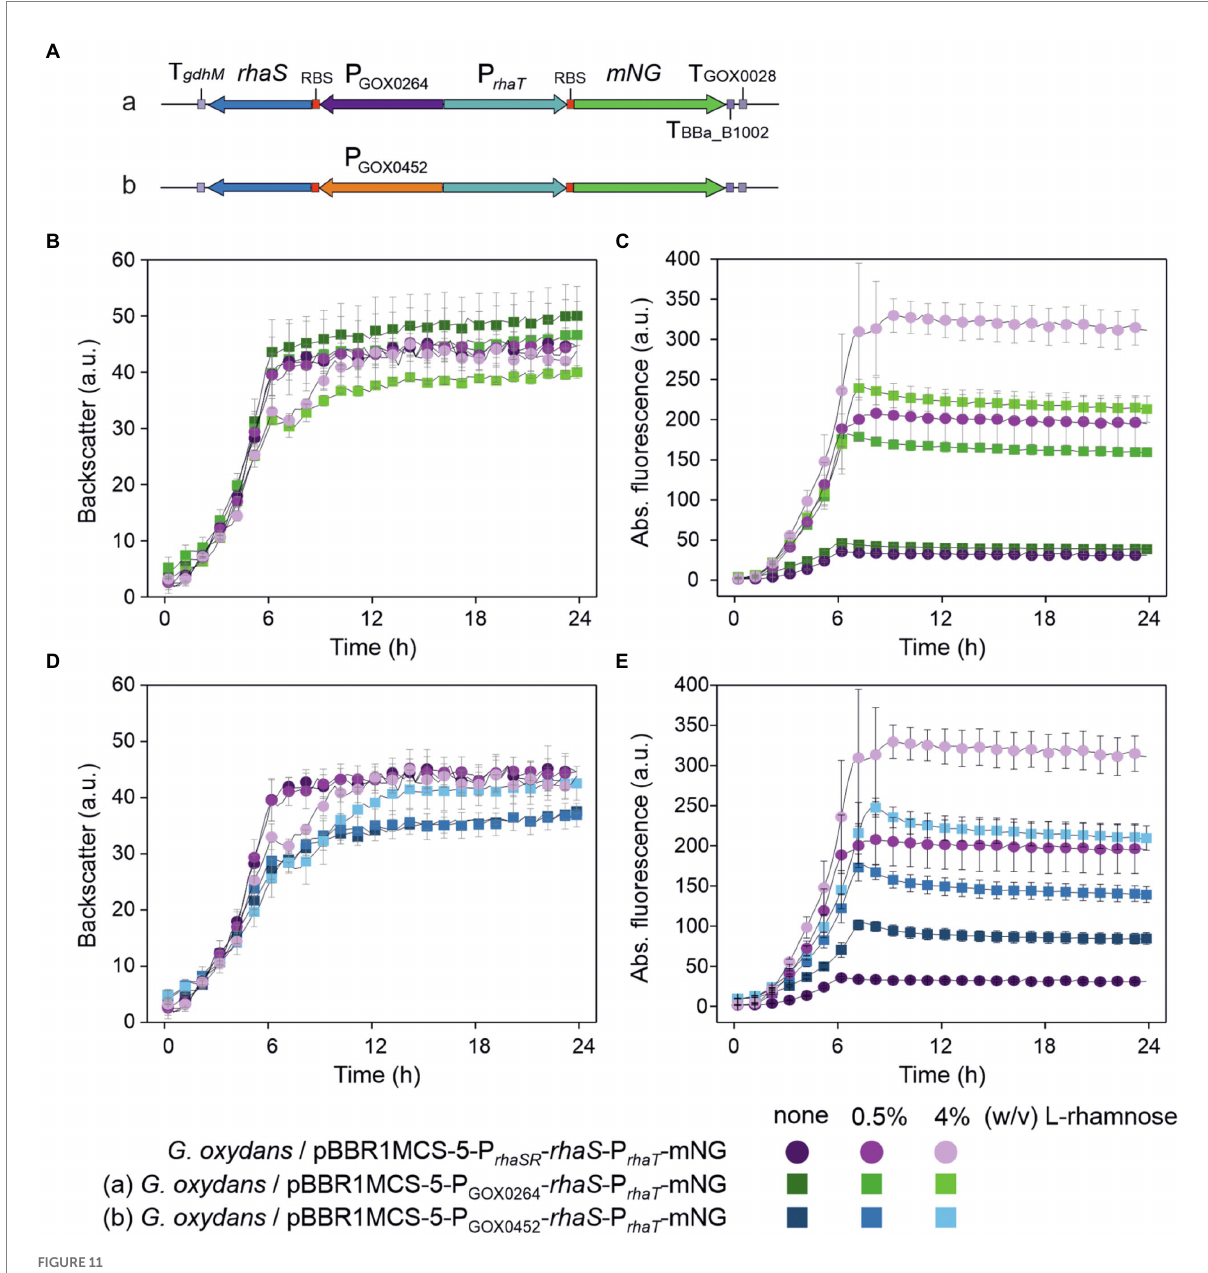
FIGURE 11 Performance of P rhaT -derived induction of mNG expression in dependence of rhaS expression and presence of l -rhamnose. (A) Schematic illustration of the pBBR1MCS-5 plasmid inserts to test the effects of rhaS expression. (B,D) Growth of the G. oxydans 621H strains with rhaS expression plasmid in d -mannitol medium according to backscatter and (C,E) absolute mNG fluorescence in BioLector cultivations. l -Rhamnose was supplemented as indicated. All data represent mean values and standard deviation from two biological replicates (clones) with three technical replicates each. BioLector settings: backscatter gain 20, fluorescence gain